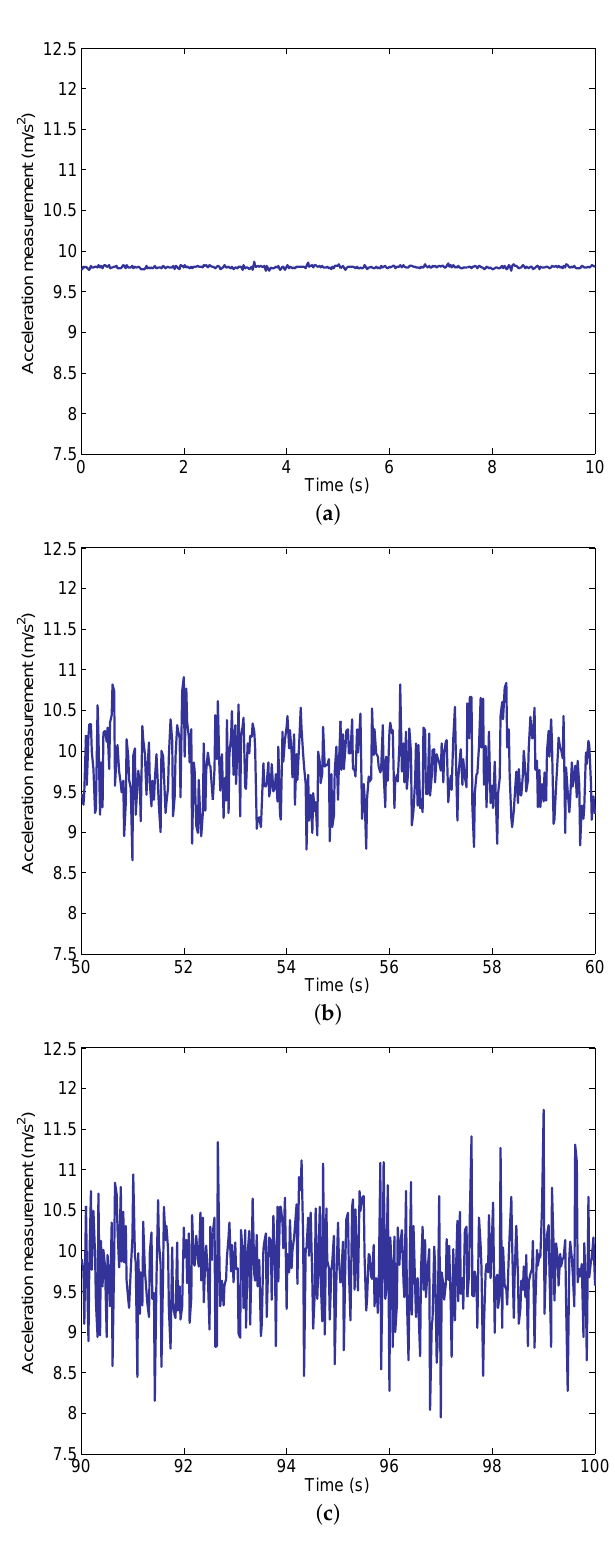
Figure 3. Vertical acceleration measurements at different engine states. ( a ) Vertical acceleration measurement before the engines start; ( b ) Vertical acceleration measurement when the engines work at idle (33,000 RPM); ( c ) Vertical acceleration measurement when the engines work close to takeoff (85,000